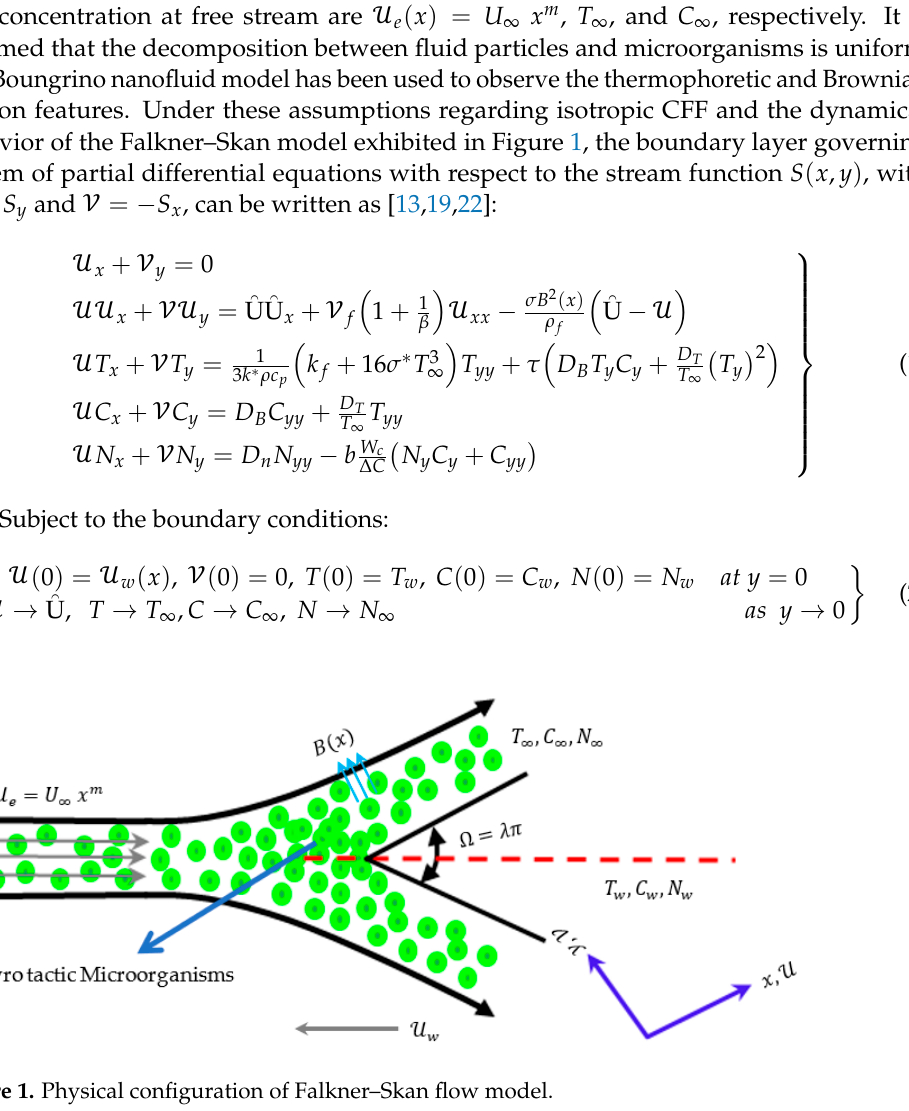
and , respectively,